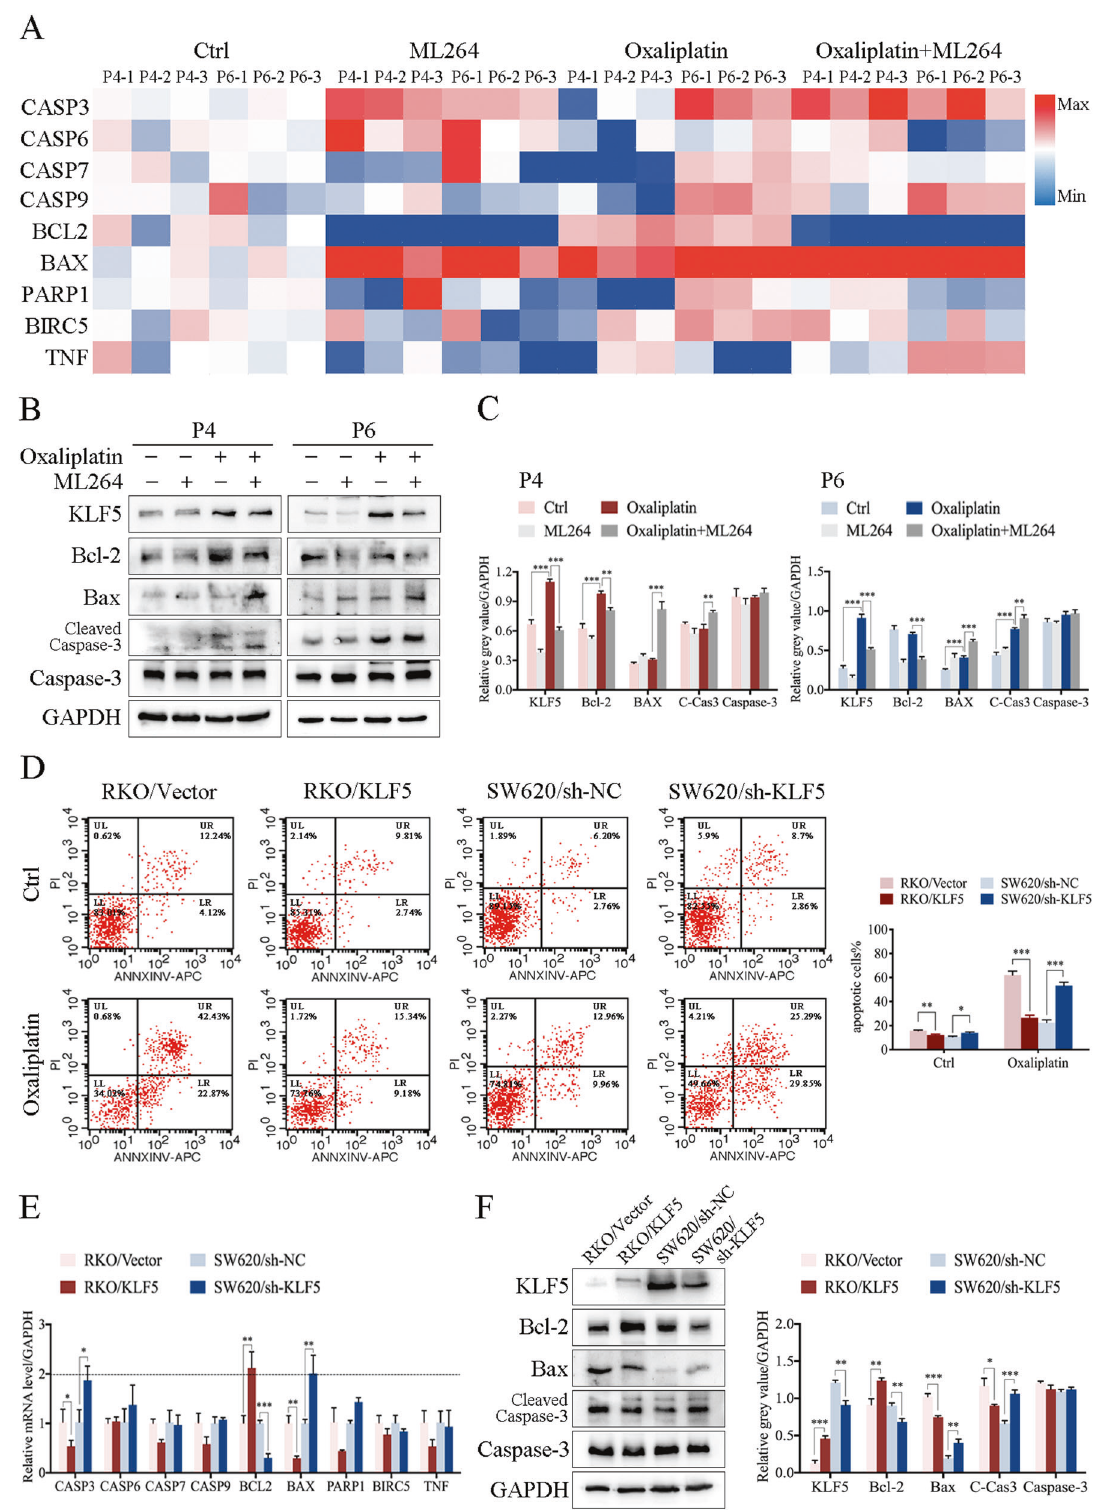
the protein level, it signi fi cantly suppresses the cleavage of caspase-3, which directly acts as an effector of caspase 3 to participate in the apoptotic response [34]. Small interfering RNA technology was used to knockdown Bcl-2 and Bax in CRC cells to investigate the pathways mediating